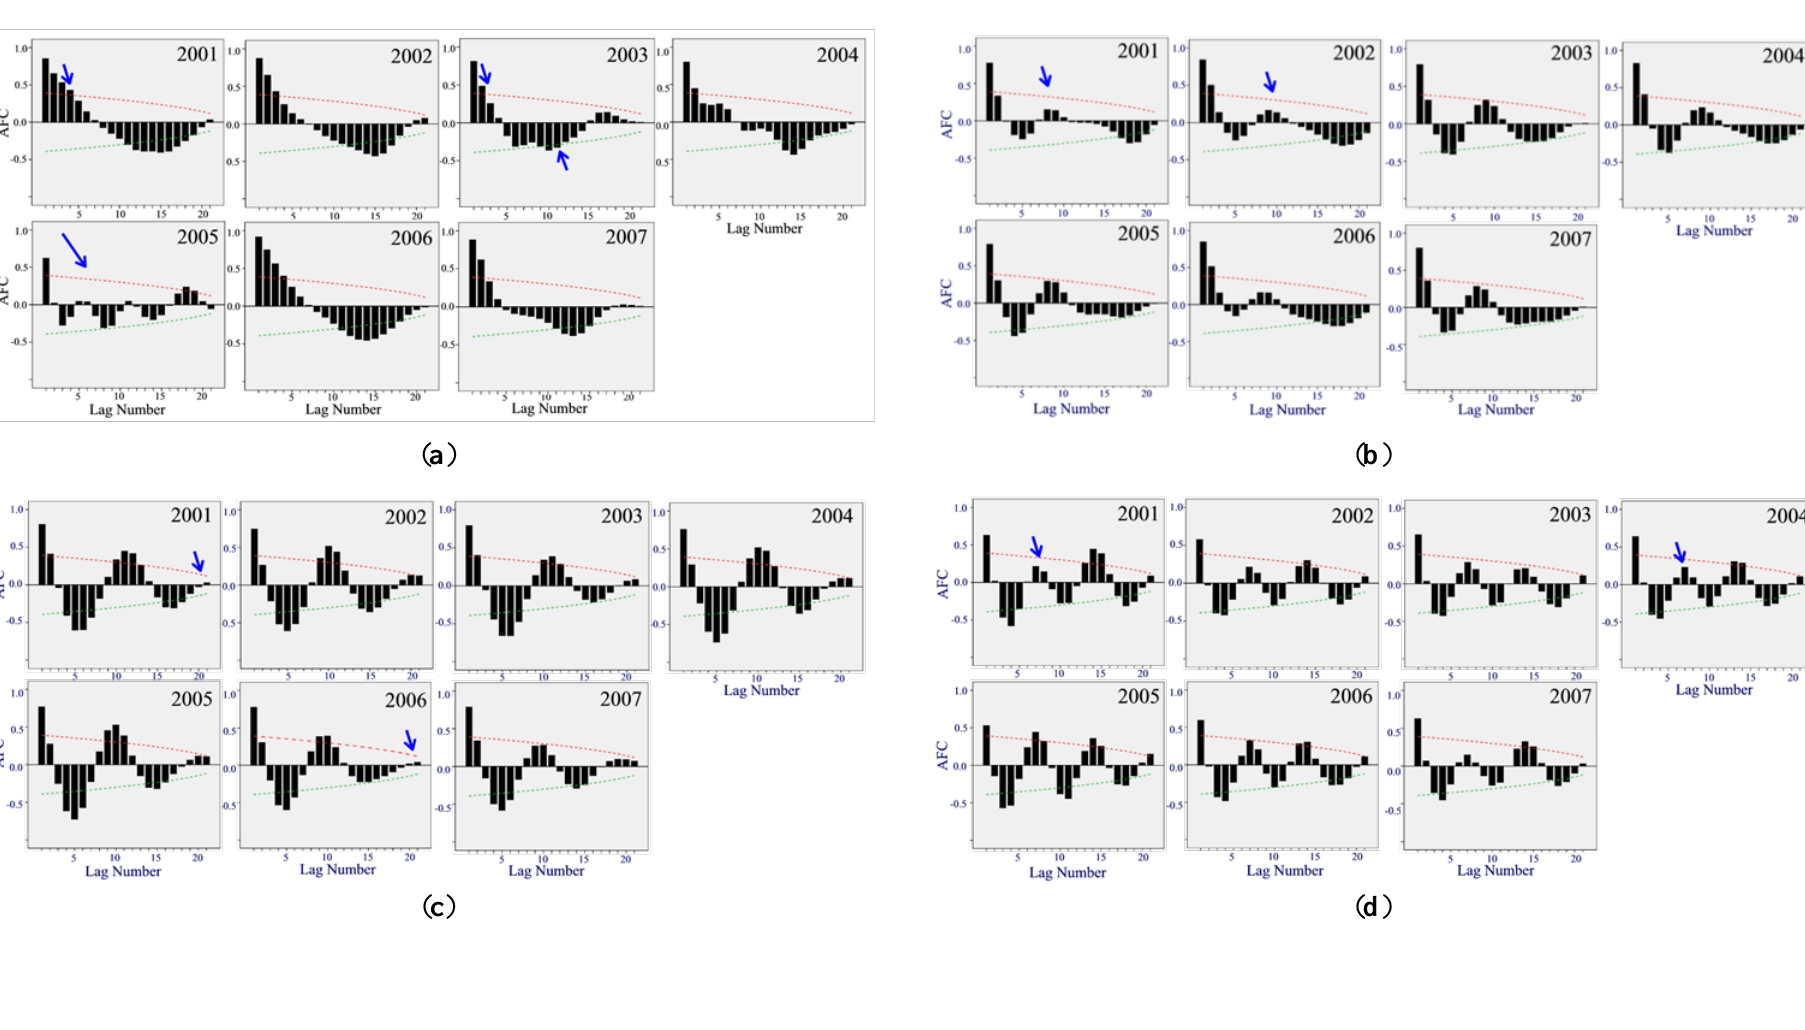
Figure 9. The inter-annual autocorrelation pattern analysis of paddy field. ( a ) Paddy field in upland area; ( b ) Paddy field with double cropping system in rain-fed area; ( c ) Paddy field in lowland and irrigated area; ( d ) Paddy field with triple cropping system in irrigated